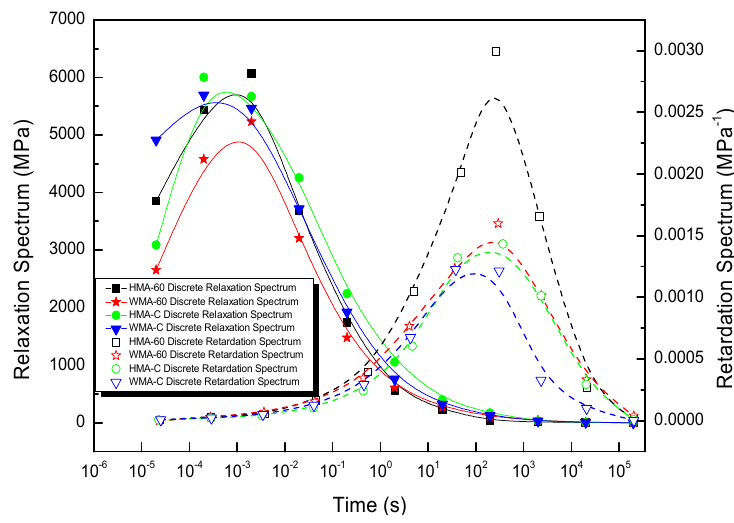
Figure 5. The discrete relaxation spectrum and retardation spectrum of asphalt mixture.